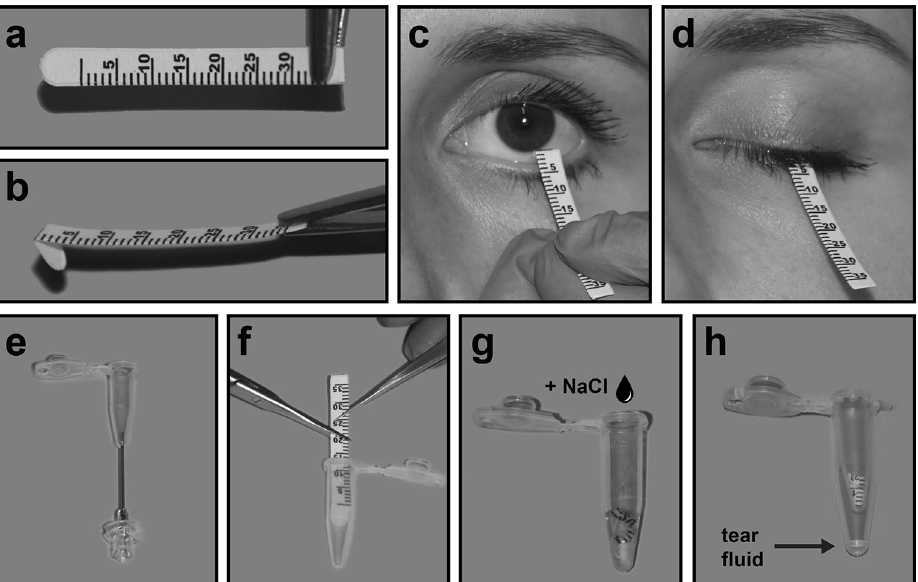
Figure 2. Tear fluid collection with Schirmer strips. ( a ) Schirmer strips are small pieces of filter paper with an imprinted graduated scale. ( b ) Strips are bent on the zero line at an angle of 120 degrees and ( c ) placed beneath the eyelid at a median position. ( d ) Eyes are closed for 5 min. ( f ) The soaked part of the Schirmer strip is cut and placed in a punctured 0.5 ml tube ( e ). ( g ) A known volume of 0.9% NaCl, proportional to the collected volume, is added for an incubation time of 2 h. ( h ) The tube containing the Schirmer strip is centrifuged into a 1.5 ml tube in order to retain the fluid.